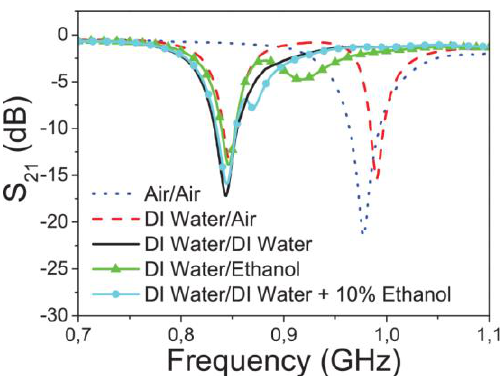
Figure 23. Measured responses of the sensor for different combinations of dielectric loads in the channels. From [58], reprinted with permission.